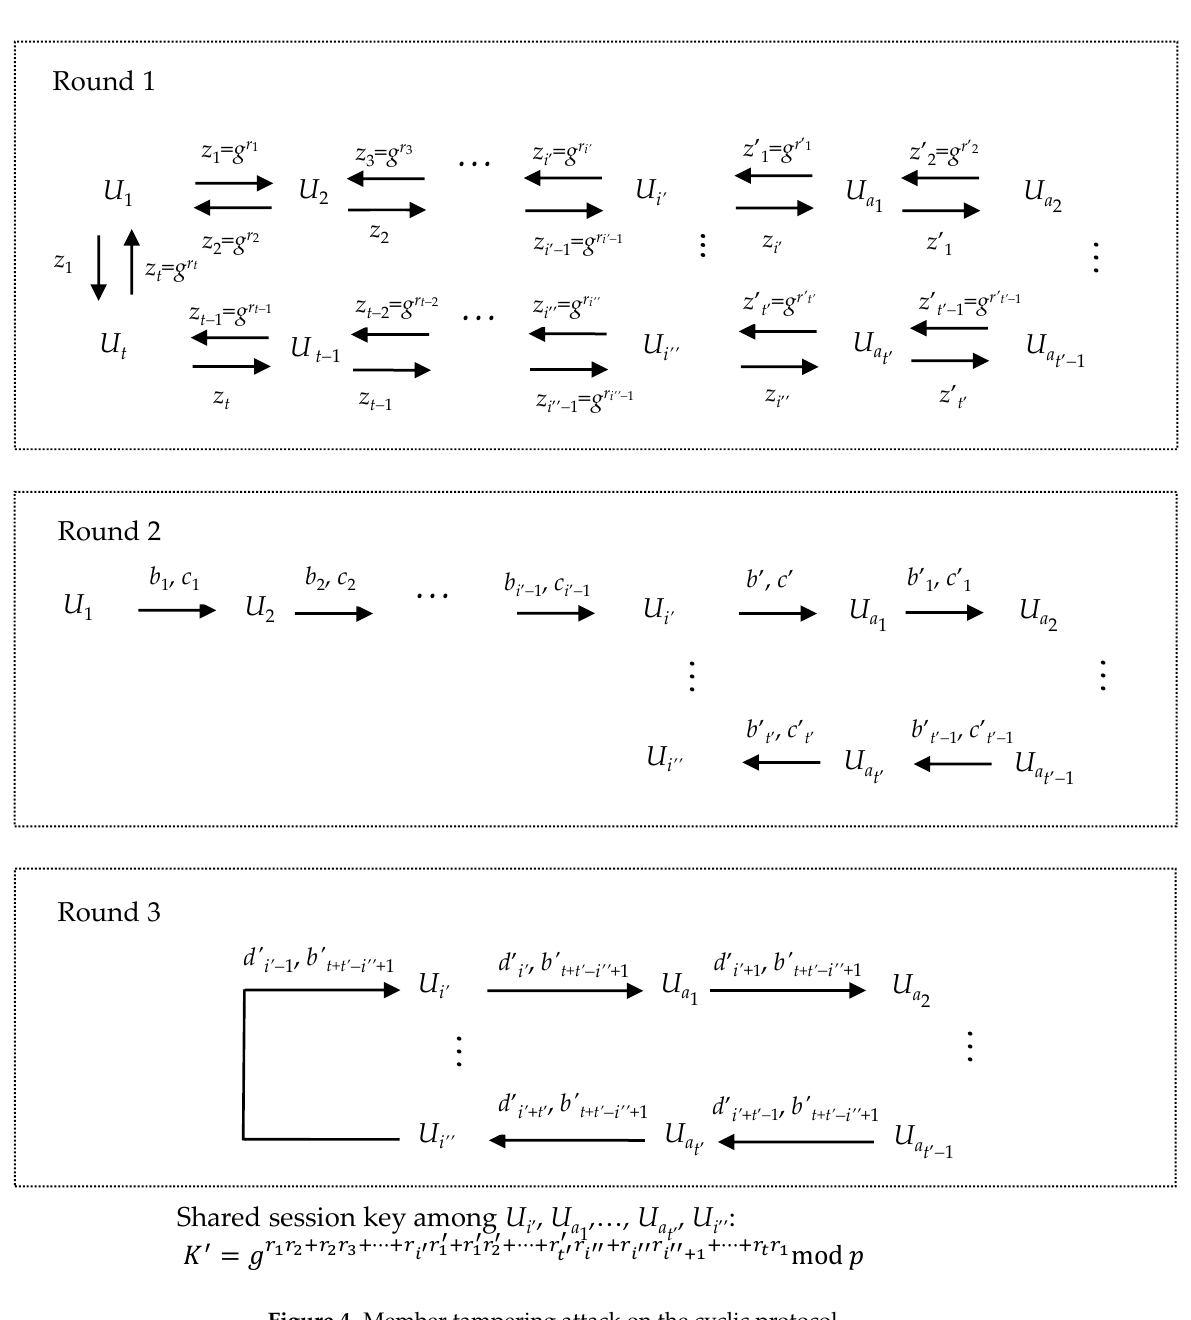
Figure 4. Member tampering attack on the cyclic